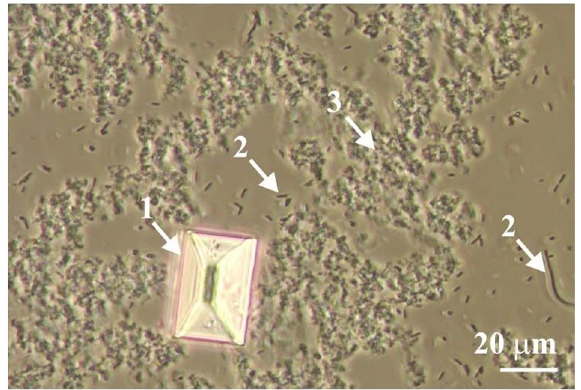
Figure 1. Struvite crystal (1), urease-positive bacteria (2) and other solid phases (PCaAP) (3) in urine 3 .